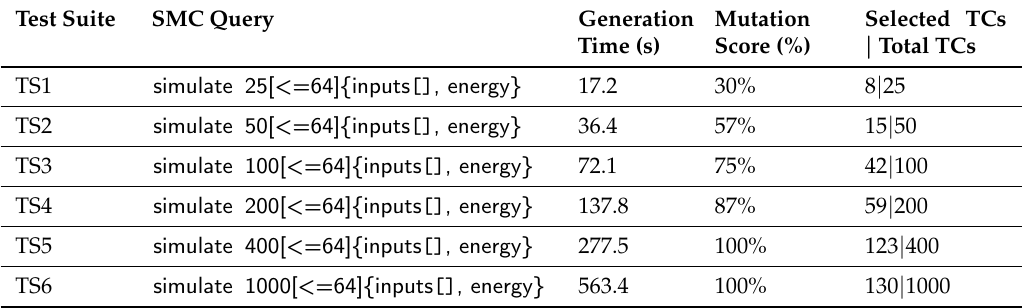
Table 2. Overall results showing the efficiency of the energy consumption test generation and mutant detection score for all generated test suites. In addition, we show the results of the test case (TC) selection based on mutation